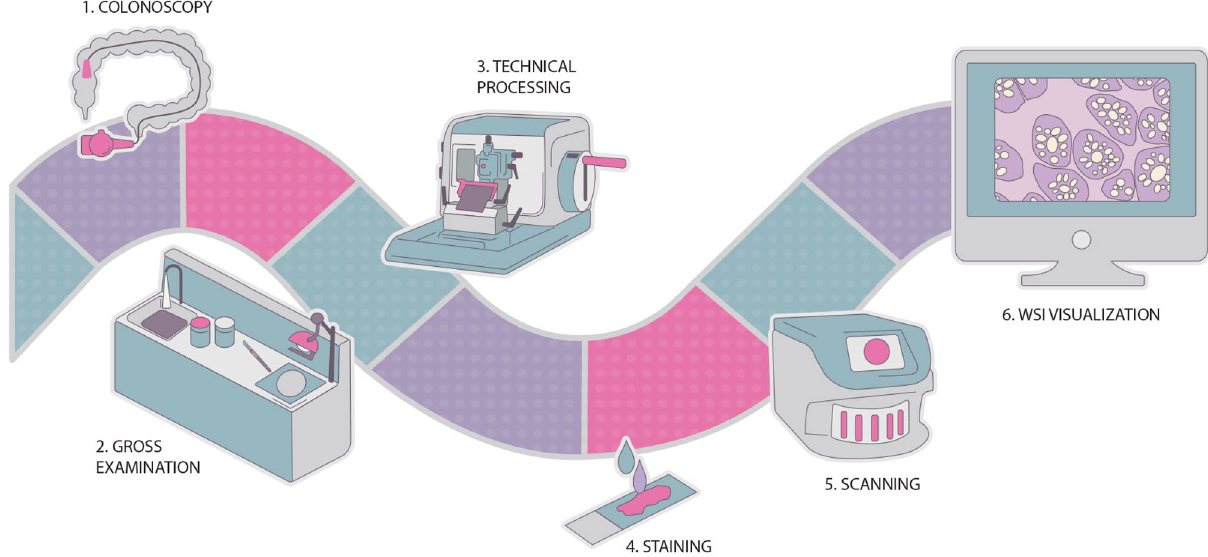
Figure 1. Digital pathology workflow, from collecting the biopsy sample to the WSI